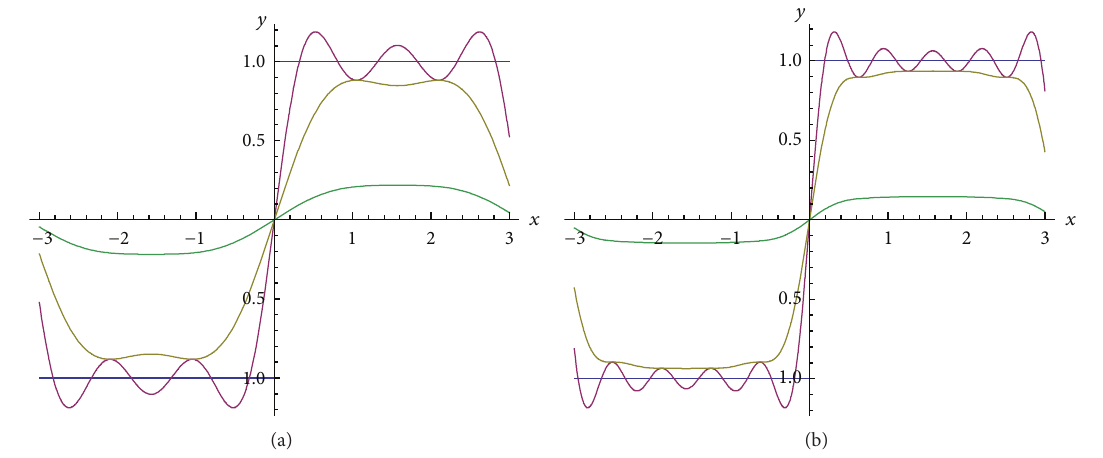
Figure 1: Graph of 𝑓(𝑥) (blue), 𝑠 𝑛 (𝑥) (pink), 𝜎 1 𝑛 (𝑥) (yellow), 𝑡 𝑁 𝑛 (𝑓;𝑥) (green), 𝑛 = 5 and